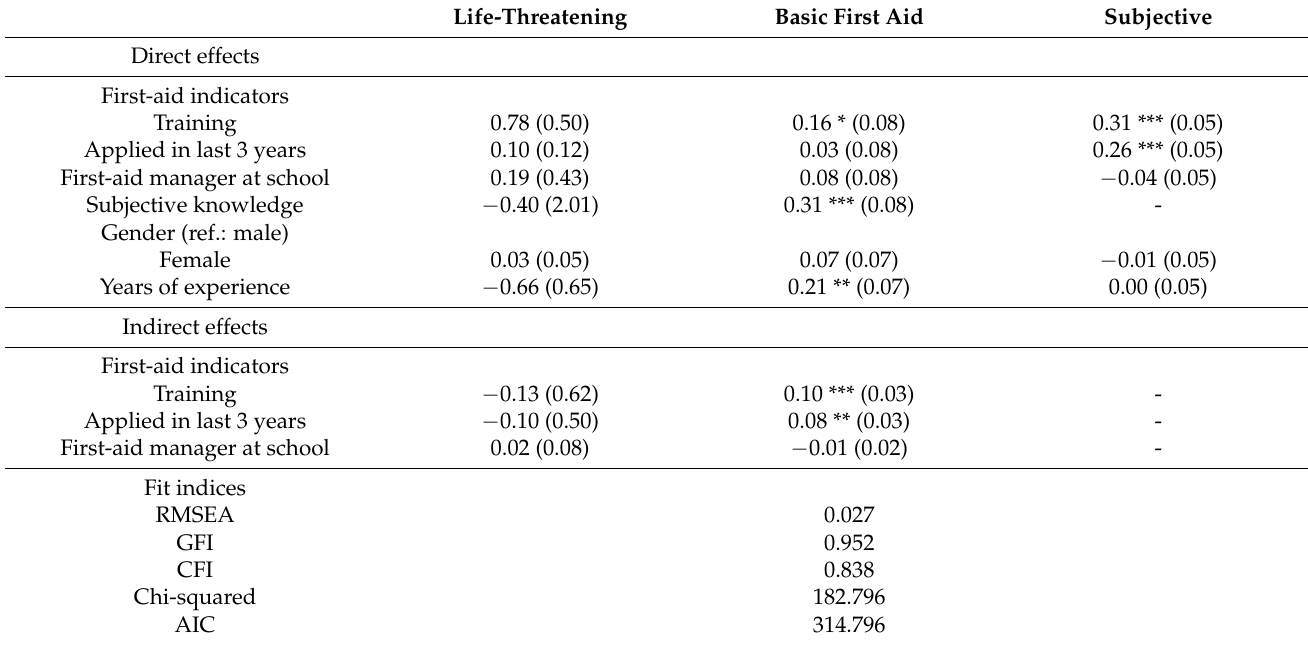
Table 4. Standardized effects of predictors on subjective and objective first-aid